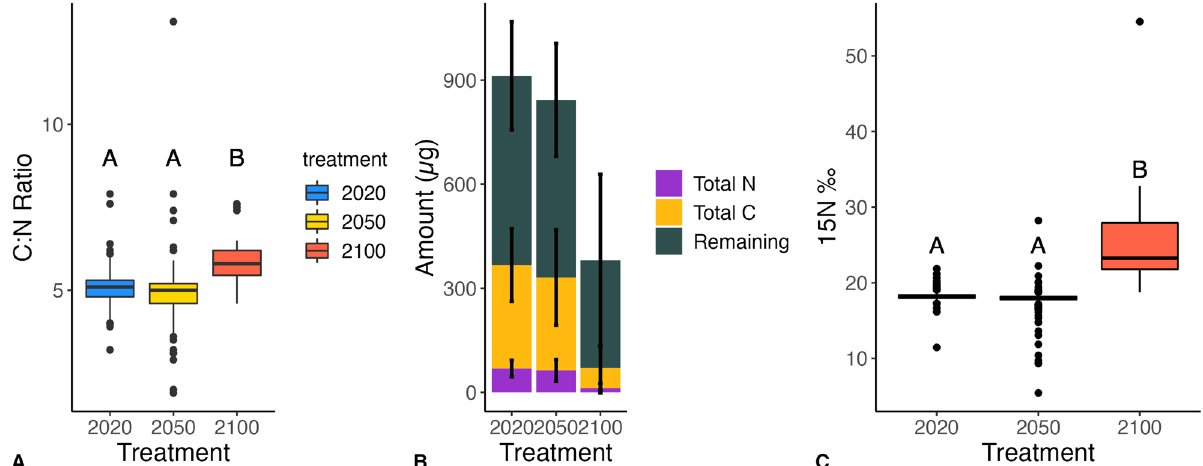
Figure 3. ( A ) Boxplots illustrating the median, upper and lower quartile, and interquartile range of the C:N ratio for the year 2020 (blue), year 2050 (yellow), and year 2100 (red) treatments (p 2020,2050 = 0.27, p 2050,2100 < 1 × 10 –4 , p 2020,2100 < 1 × 10 –4 ). ( B ) fraction of total weight (μg) comprised of total N and total C for each treatment. C) Boxplots illustrating the median, upper and lower quartile, and interquartile range of the concentration (per mille) of nitrogen-15 in each treatment (p 2020,2050 = 0.57, p 2050,2100 < 1 × 10 –4 , p 2020,2100 < 1 × 10 –4 ). Nested mixed model ANOVAs were run to determine statistical significance, letters indicate significant